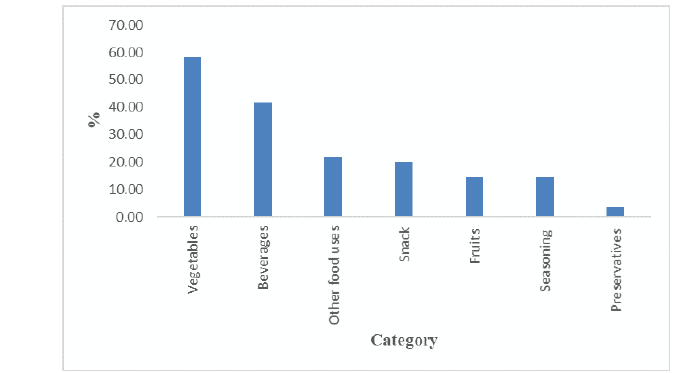
Figure 7 Categories of edible plants based on folk knowledge, as a